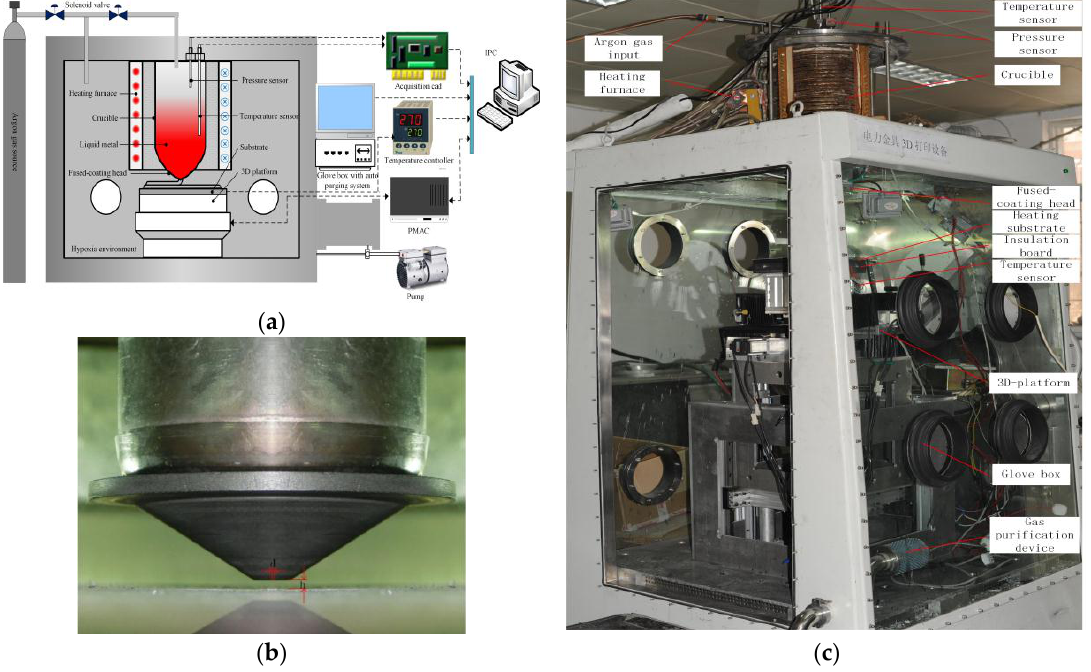
Figure 1. ( a ) Molten metal micro-coating equipment schematic diagram. ( b ) Nozzle practicality picture. ( c ) Molten metal micro-coating equipment practicality picture.